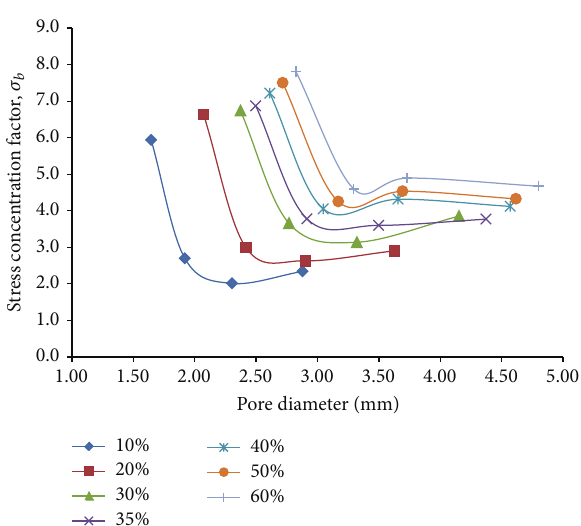
Figure 12: Plots depicting variation of stress concentration factor, 𝜎 𝑏 , against pore diameter for different percentages of porosity for 3D porous FE beam models subjected to flexural loading only.